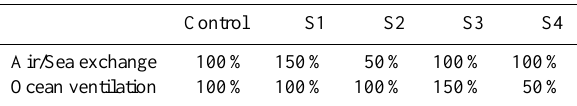
Table 1. Performed carbon cycle sensitivity experiments. All per- centage values refer to the control simulation under pre-industrial